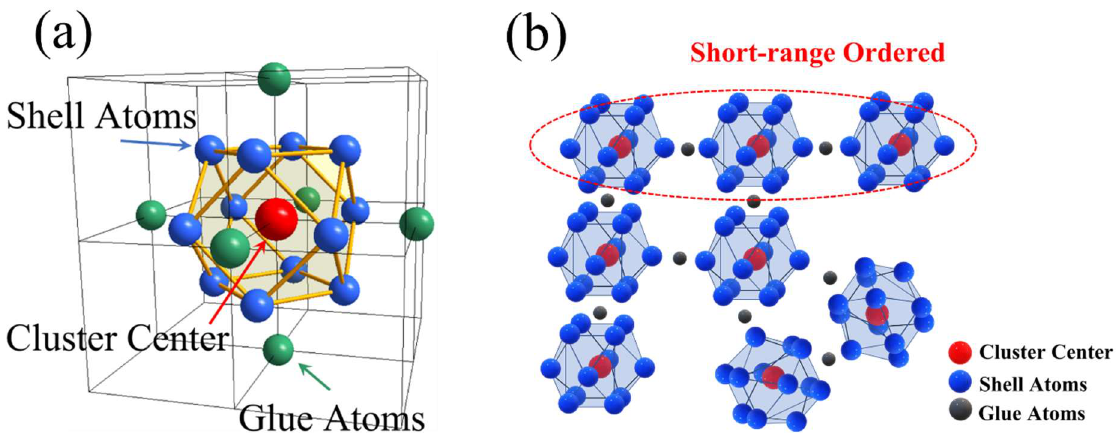
Figure 1. ( a ) Cluster-plus-glue-atom model of FCC solid solutions; ( b ) Short-range